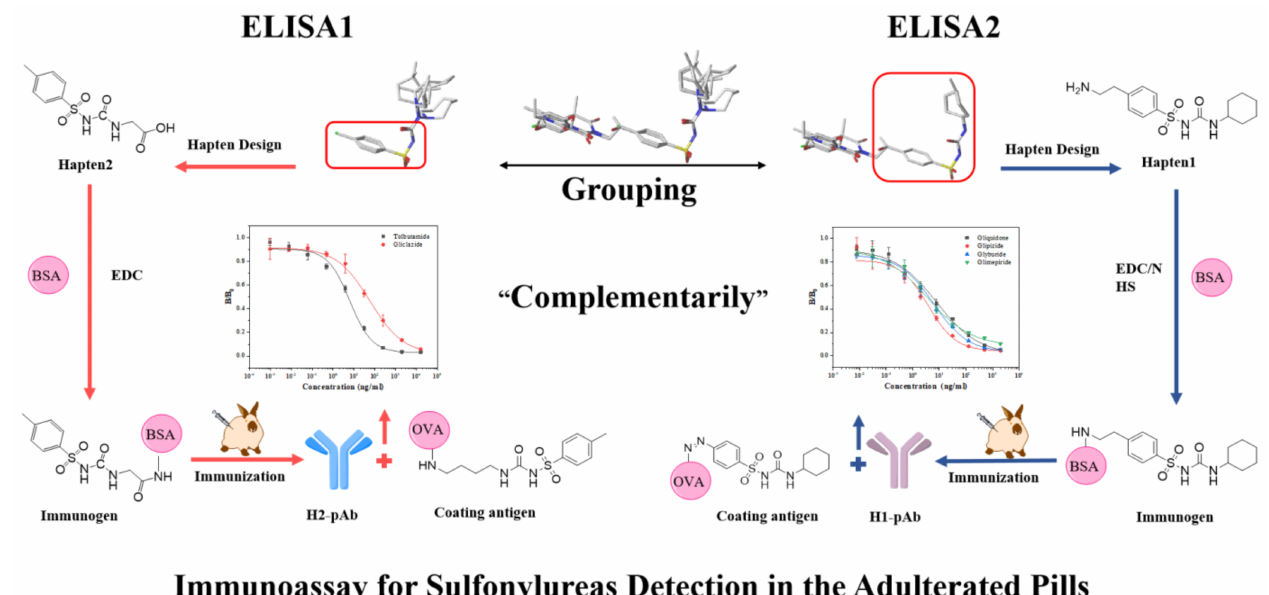
Figure 1. Schematic illustration of complementary ic-ELISA for Sulfonylureas. H1-pAb, antibody to Hapten 1. H2-pAb, antibody to Hapten 2. BSA, bovine serum albumin. EDC/NHS, two coupling regents EDC and NHS for active ester